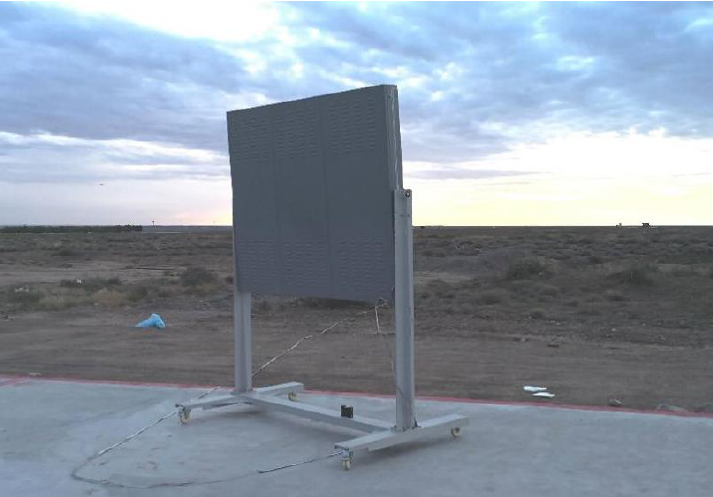
Sensors 2020 , 20 , x FOR PEER REVIEW Figure 8. Picture of L-band array radar outfield. Figure 8. Picture of L-band array radar outfield.